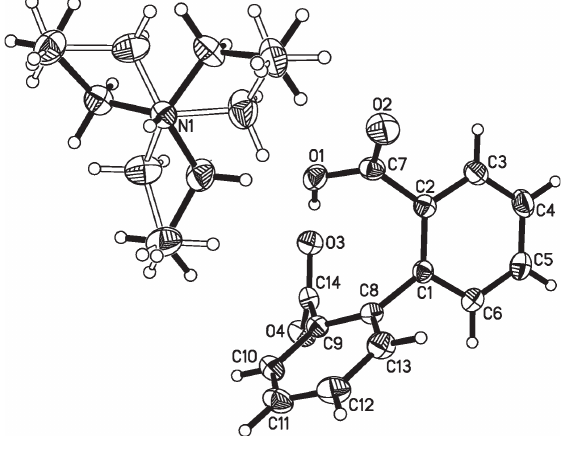
Table 2: Fractional atomic coordinates and isotropic or